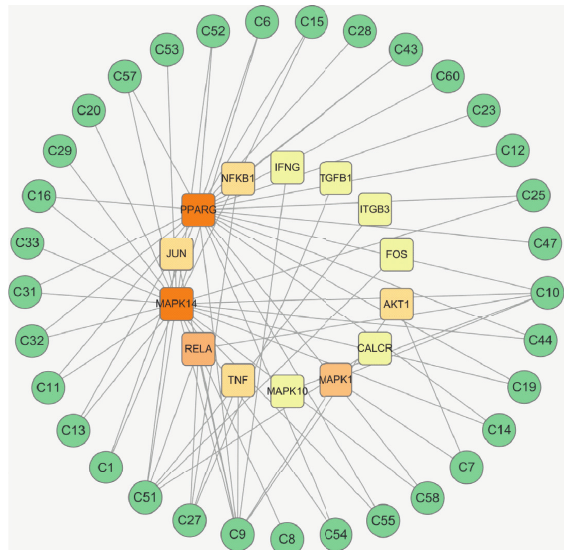
Figure 5: Active components corresponding to key core targets.